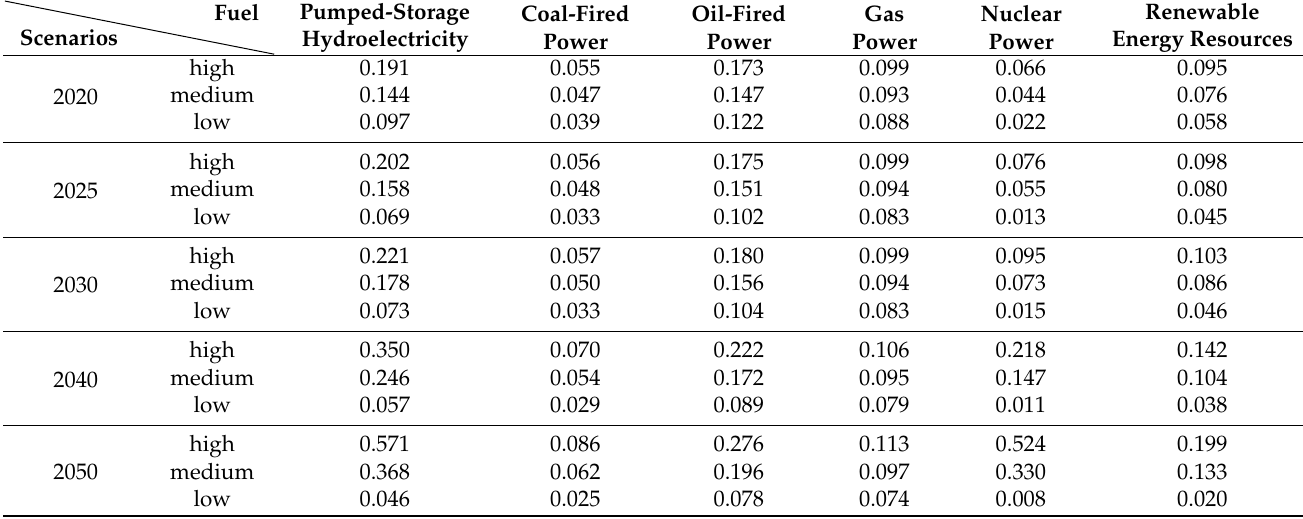
Table 2. Estimation of unit power generation cost in high, medium and low scenarios. Unit: US$/kWh. Scenarios